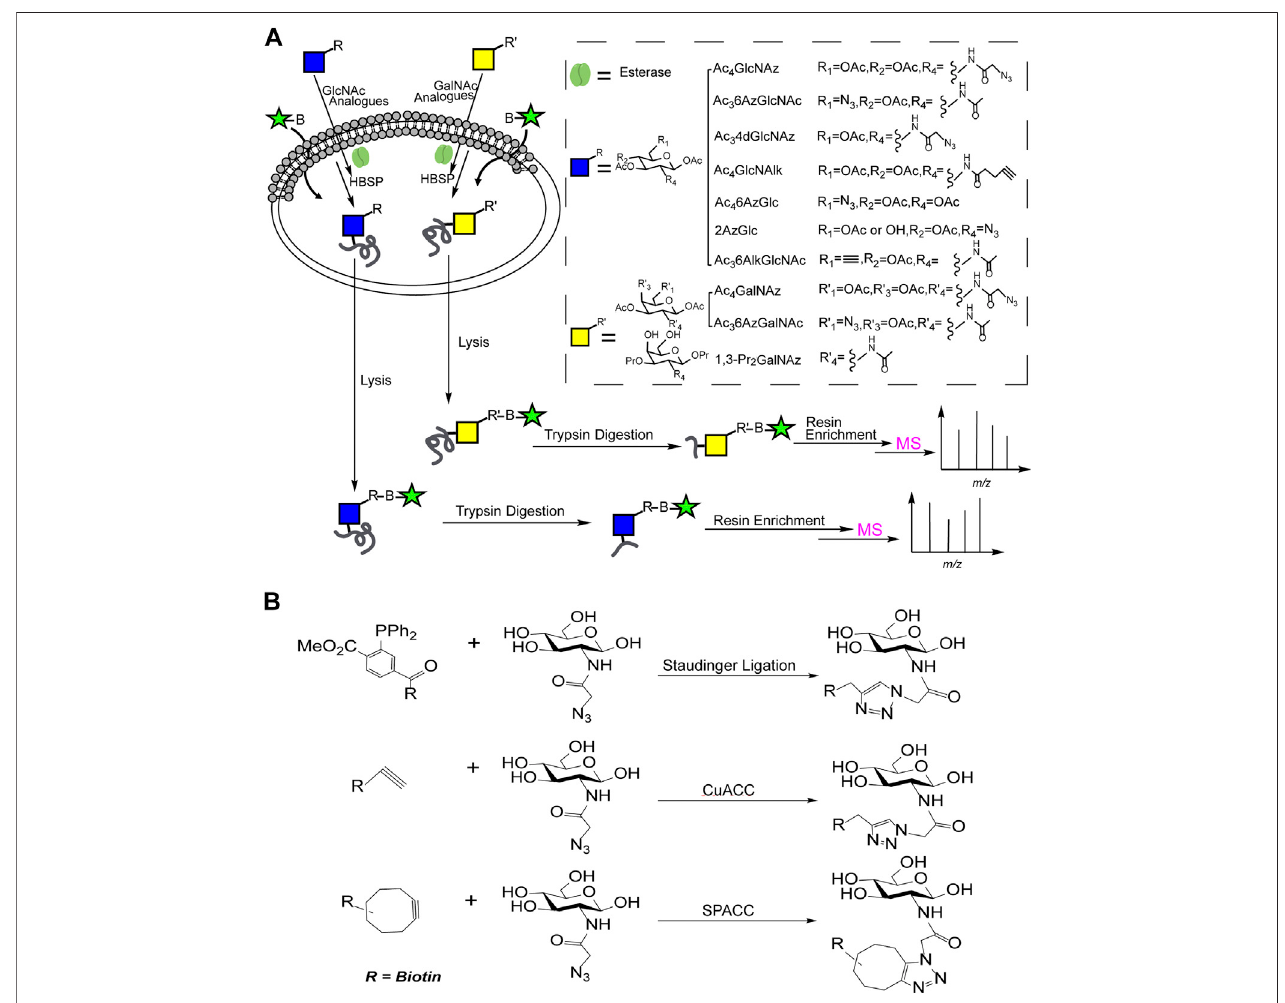
FIGURE1|(A) ThecombinationofMOEandsolidphaseenrichmentforMSpro fi lingofO-GlcNAcylatedproteins; (B) Reactionsinvolvedinsolidphaseenrichment of O-GlcNAcylation.